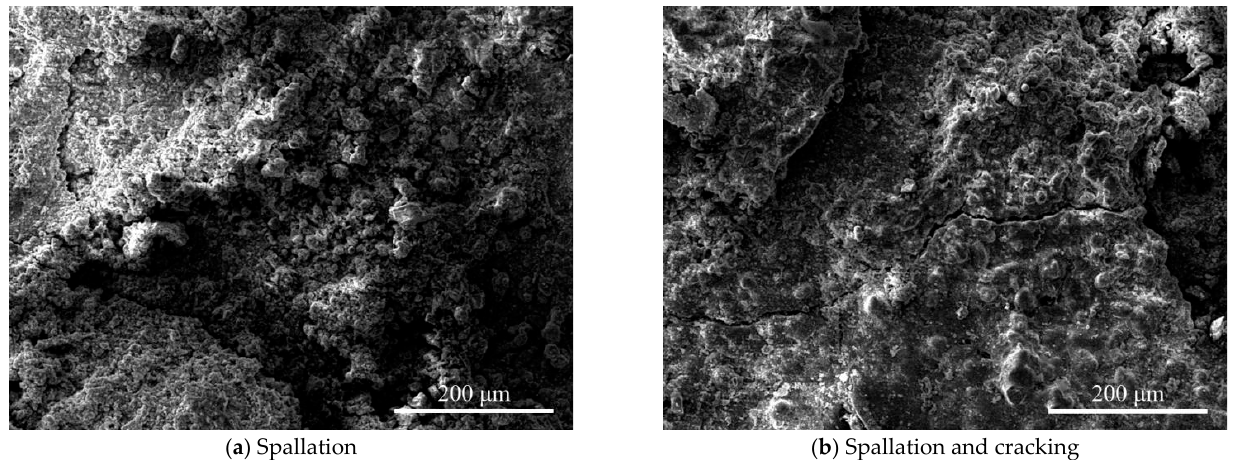
Figure 13. Micromorphology of the rust layer after 84 months of atmospheric exposure.